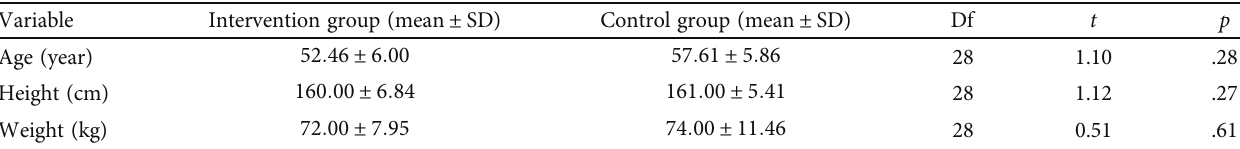
Table 1: Demographic variables of